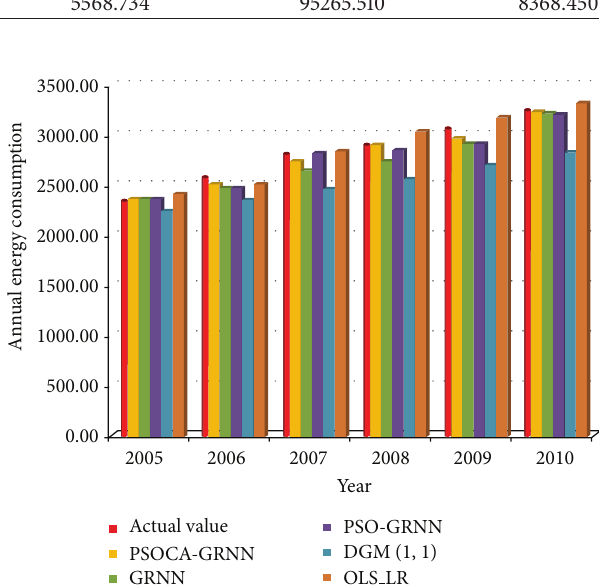
Figure 6: Annual energy consumption forecasting results with the PSOCA-GRNN, GRNN, PSO-GRNN, DGM (1, 1), and OLS LR models.